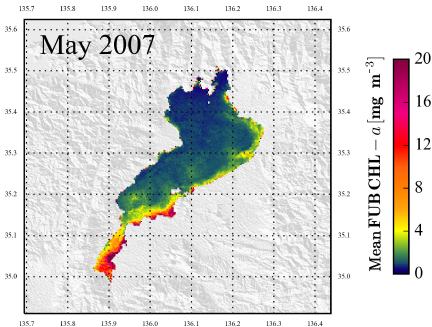
Figure 12. Chl in Lake Biwa, May 2007; L3 aggregate of four cloud-free images and one partly cloudy image ( chl_fub_mean